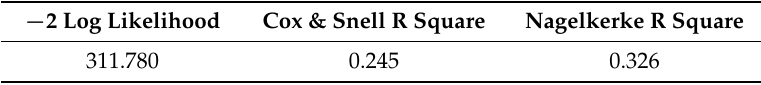
Table 3. Maximum likelihood estimation and Cox and Snell’s and Nagelkerke’s R-square.